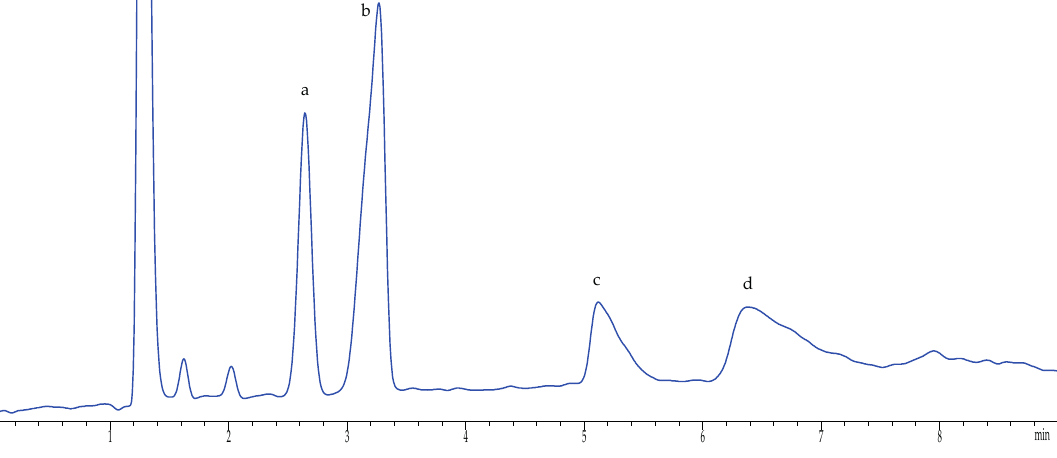
Figure 15. Chromatogram of the model solution of D-glucose ( a ), D-fructose ( b ), sodium salt of D-gluconic acid ( c ), and D-glucuronic acid ( d ).